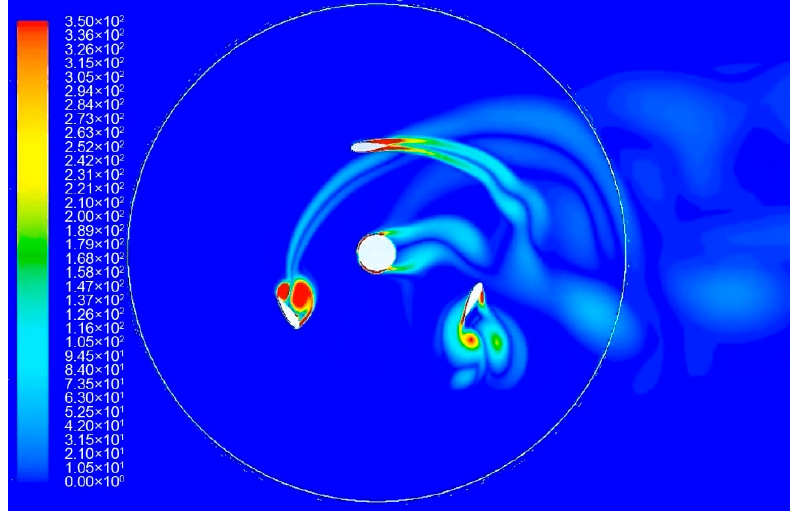
Figure 9. Velocity map in the turbine’s cross section at 10 m/s of wind speed.